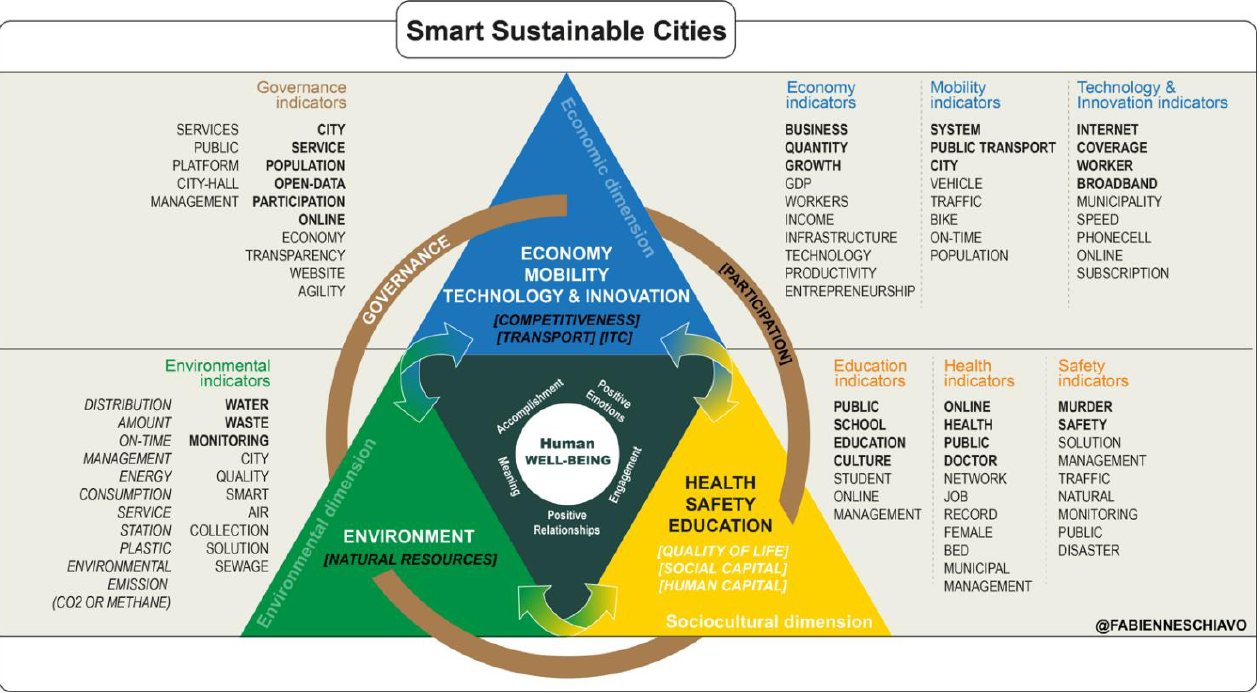
Figure 21. Synthetic scheme to plan initiatives for smart sustainable cities — a new proposal.